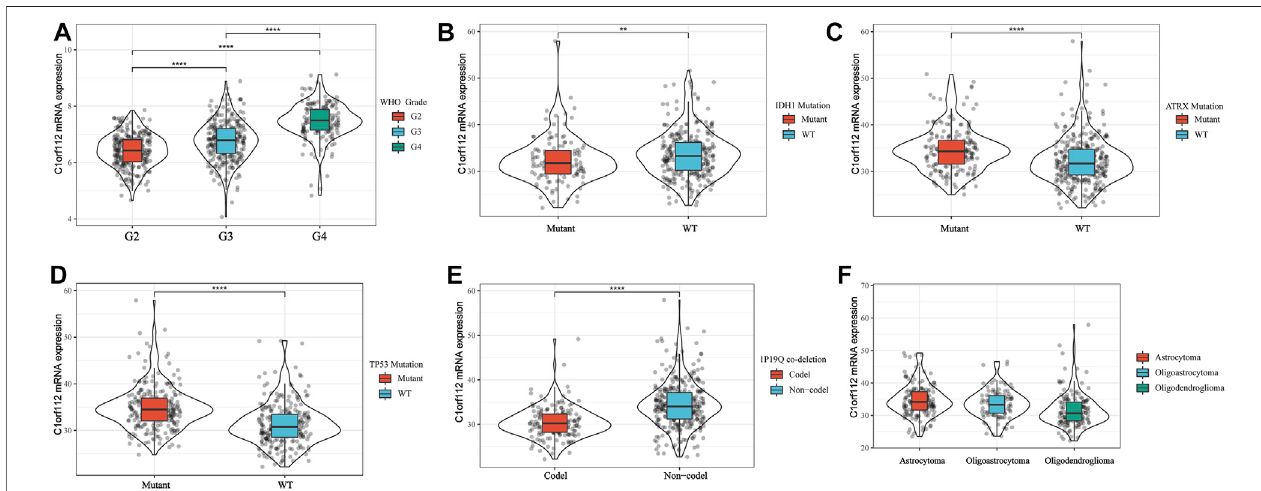
FIGURE 3 | Genetic alterations and prognostic value of C1ORF112 expression in low-grade gliomas. (A) Mutation rate of C1ORF112 in LGGs. (B) Putative copy number alterations of C1ORF112 in LGGs. (C) Survival curves of OS from TCGA dataset ( n (cid:1) 511). (D) Survival curves of OS from Rembrandt dataset ( n (cid:1) 161).